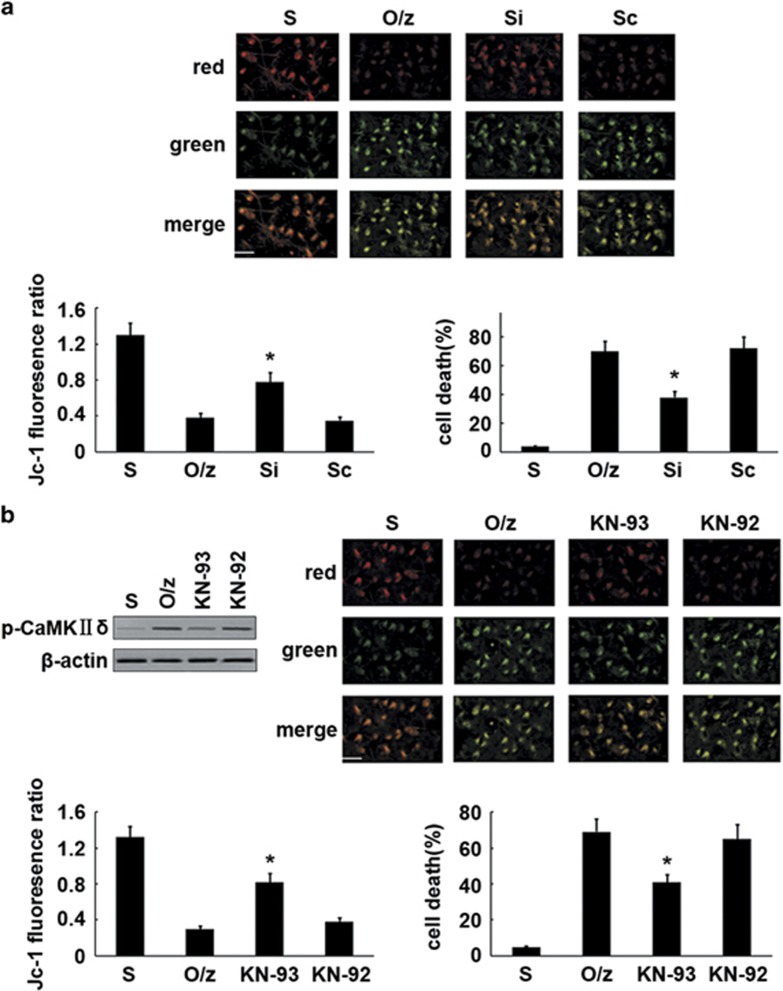
ΔΨm collapses after OGD/zVAD insult in OPCs. (a) Representative photomicrographs of JC-1 staining and quantification of the JC-1 fluorescence ratio. The JC-1 fluorescence ratio was calculated using the average red/green optical density ratio. A low ratio represents a dissipation of ΔΨm. OGD/zVAD led to dissipation of ΔΨm in OPCs 24 h after OGD. RIPK3 inhibition via siRNA attenuated the dissipation of ΔΨm and enhanced OPCs survival 24 h after OGD. Data are presented as means ±S.E.M. from three independent experiments. N=6 for each group in each experiment (scale bar=40 μm) (P<0.05, comparing the siRNA group with the OGD/zVAD group). S: sham; O/z: OGD/zVAD; Si: RIPK3 siRNA; Sc: RIPK3 siRNA scramble. (b) KN-93 inhibits CaMKIIδ phosphorylation in OPCs in the OGD/zVAD group 12 h after OGD, attenuates the dissipation of ΔΨm 24 h after OGD, and enhances OPCs survival 24 h after OGD. Data are presented as means±S.E.M. from three independent experiments. N=6 for each group in each experiment. (Scale bar=40 μm) (P<0.05, comparing the KN-93 group with the OGD/zVAD group). S, sham; O/z, OGD/zVAD; KN-93, CaMKII inhibitor; KN-92, negative control for KN-93